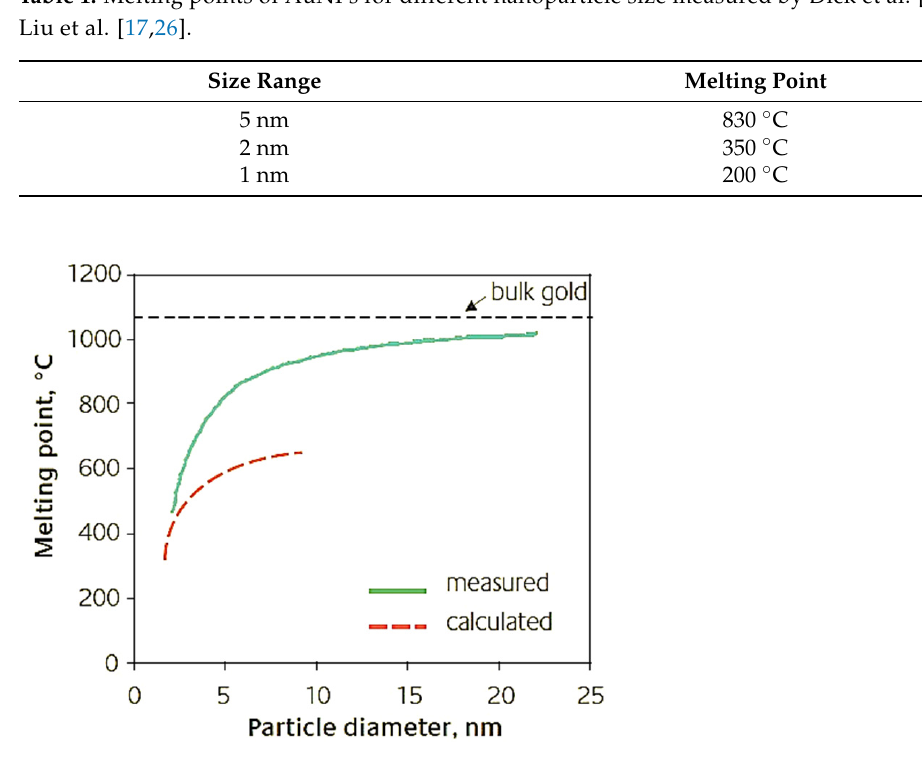
Figure 4 . Cartesian graph of the different values of the melting point vs. AuNPs’ dimensions [17]. AuNPs can be obtained from different synthesis procedures that allow us to modulate their size and shape [27]. The most common shapes are nanospheres, nanorods, nanoprisms, nanowires, nanocages and nanostars (Figure